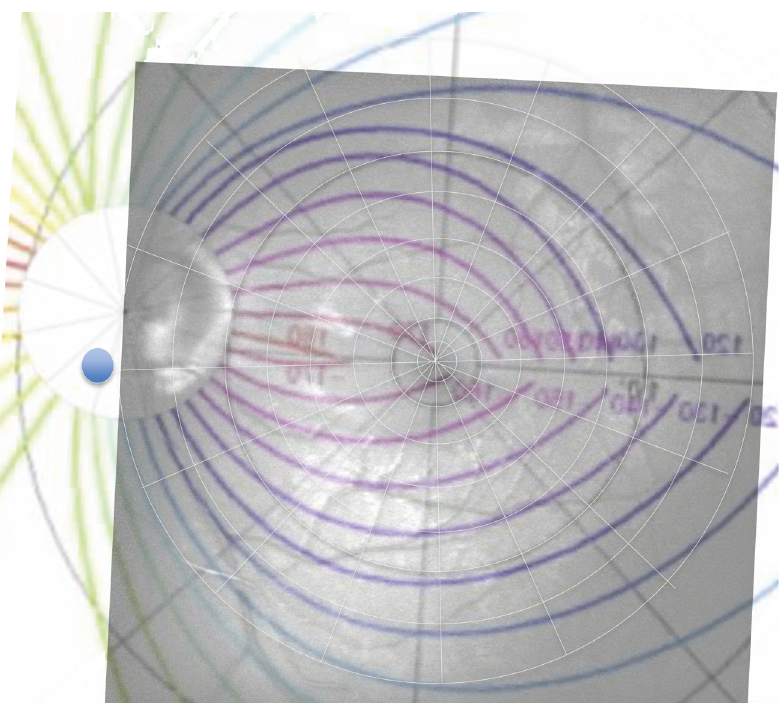
Figure 4: Nerve fi ber course model (Jansonius et al.) with superimposed visual fi eld (VF) program to analyze the corresponding RNFL sector OCT value referring to the VF patterns